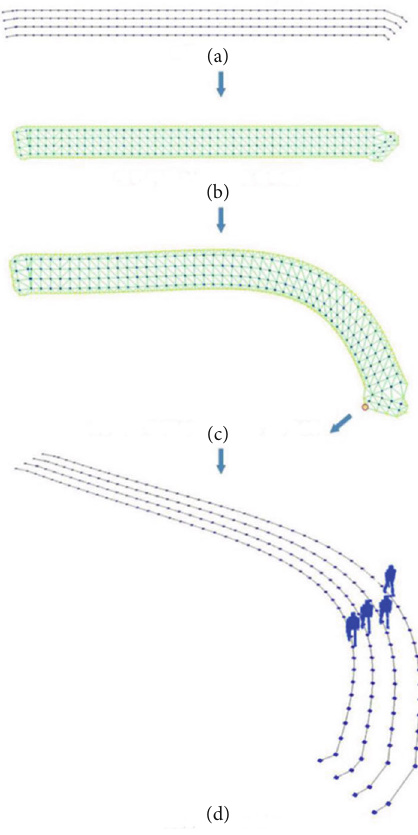
Figure 12: Adjustment of the vertices on the bounding shell. Table 1: Hardware con fi guration of the experimental platform. Con fi guration and parameters of the hardware